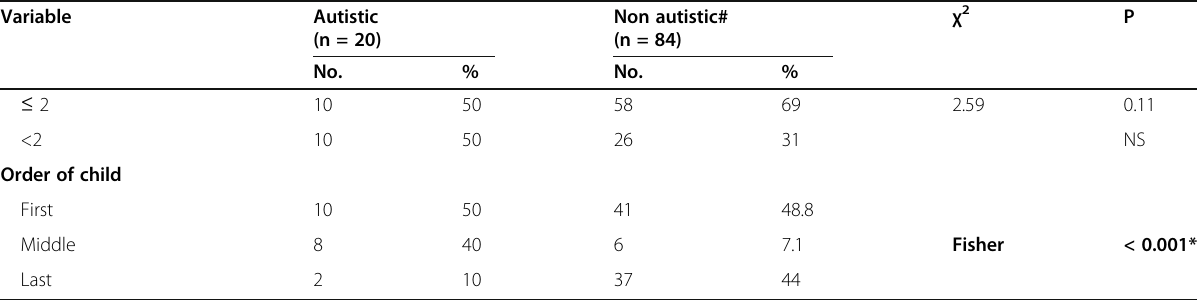
Table 2 Comparison between autistic and non-autistic children in demographic data (Continued)